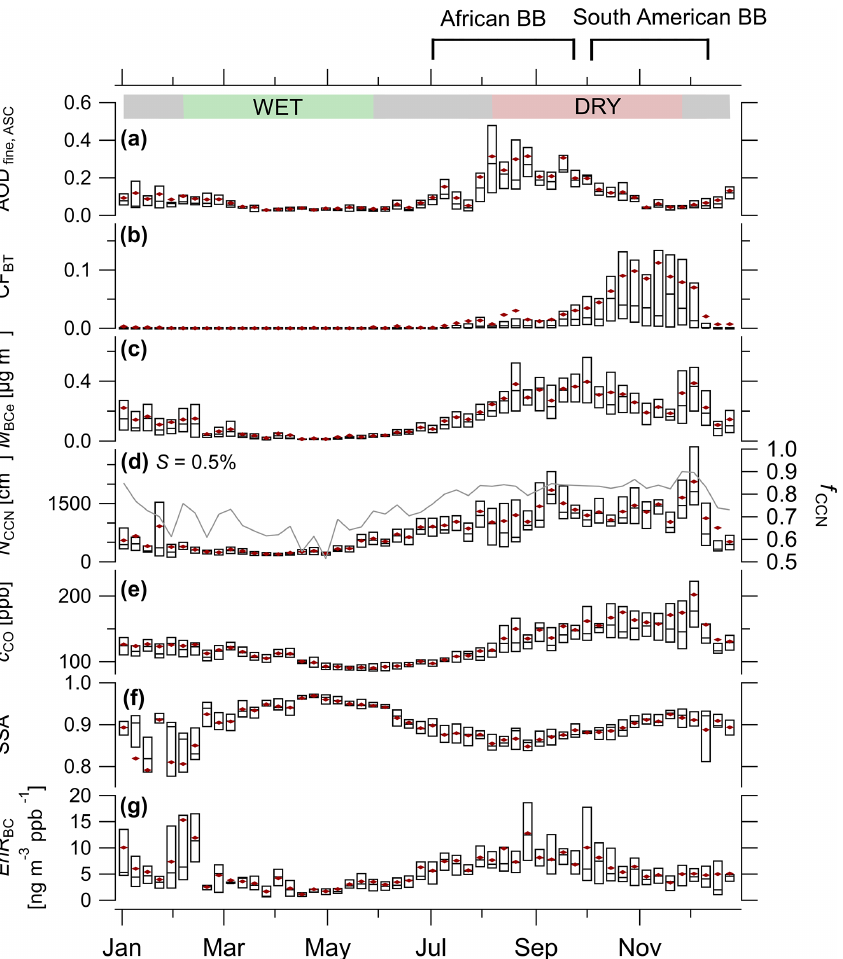
Figure 12. Seasonality of aerosol and trace gas properties based on long-term observations (2013–2018) at Ascension Island (a) and at the ATTO site (b–g) . The plot shows (a) fine-mode aerosol optical depth (AOD fine ) at 500nm retrieved by the AERONET sunphotometer at Ascension Island; (b) cumulative fire intensity along the backward trajectories (CF BT ) of air masses arriving at the ATTO site (for details, see Sect. 2.6); (c) black carbon mass concentration M BC ; (e) CCN concentrations and activated fraction at S = 0 . 5%; (e) CO mole fraction; e (f) single scattering albedo, SSA; and (g) BC enhancement ratio, EnR BC . The boxplots represent weekly statistics with the mean (red markers), the median (segment), and the 5th and 75th percentiles (lower and upper box edges) of the long-term daily measurements. The green and red shaded areas represent the wet and dry seasons, with transition periods in between, as defined in Pöhlker et al. (2016). On the top of the figure, markers indicate periods within the BB-influenced part of the year that ATTO is dominated either by the LRT of African BB or by the South American